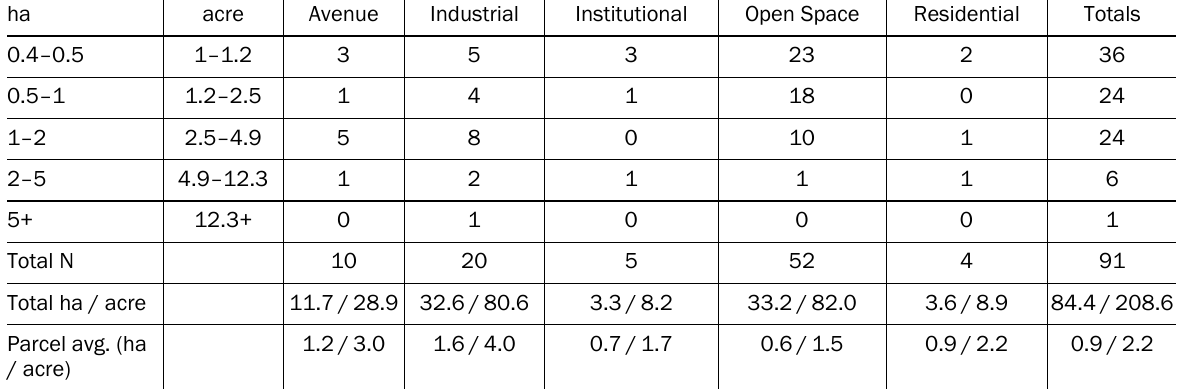
Table 3. Number of Growing Parcels in Etobicoke, Organized by Zoning and Parcel Size